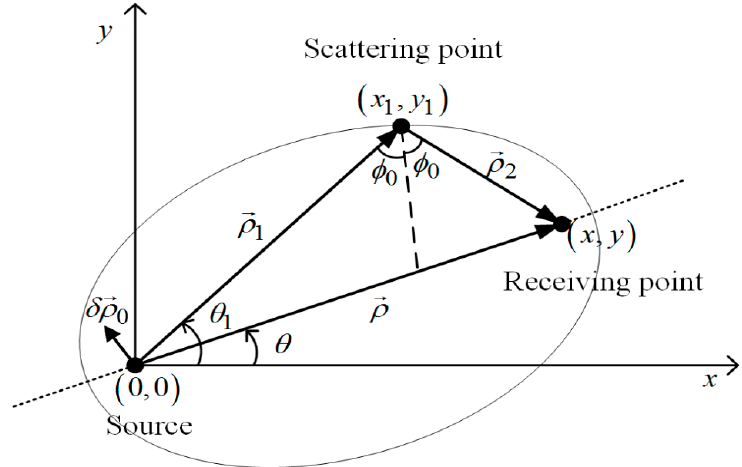
( ) 0,0 → ρ 0 → ρ is the displacement 1